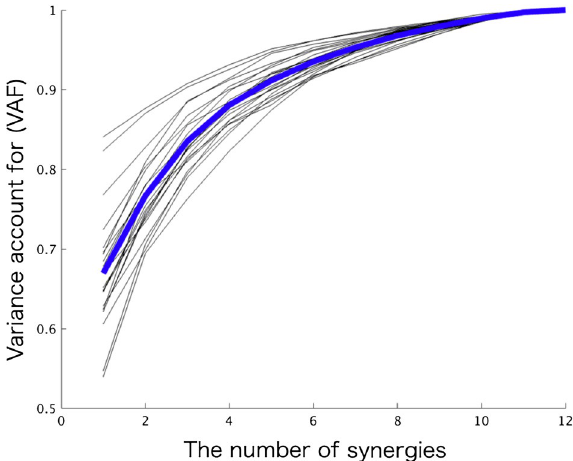
Figure 4. Individual (black thin lines) and participant (blue thick line) means of the percentage of variability accounted for (VAF). When 5 synergies were extracted, the mean value of VAF is 91.3% (± 0.02).